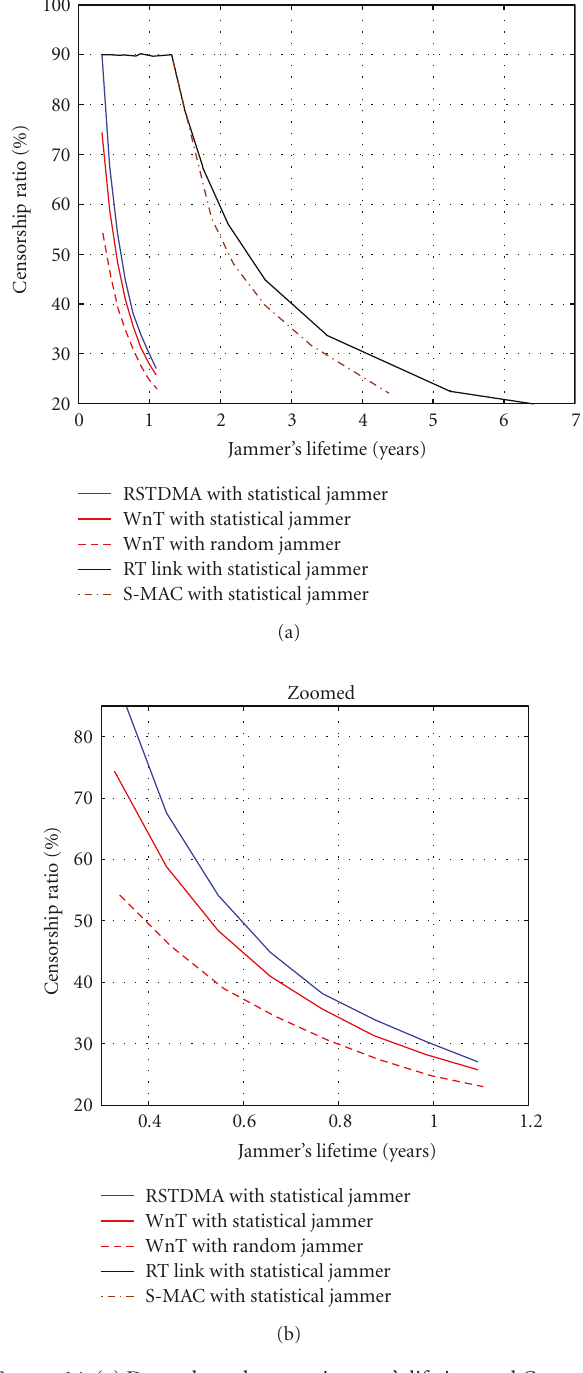
Figure 14: (a) Dependency between jammer’s lifetime and Censor- ship Ratio and (b)